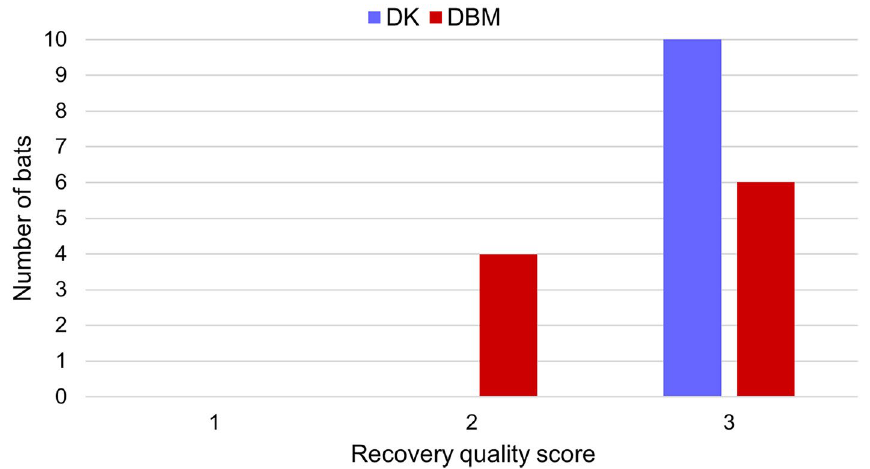
Figure 4. Recovery quality scores in 20 Egyptian fruit bats anaesthetized for gonadectomy. Bats in group DK (n = 10) received DEX and KET combination and bats in group DBM (n = 10) received DEX, BUT and MDZ administration. Significant differences ( p < 0.05) between groups were